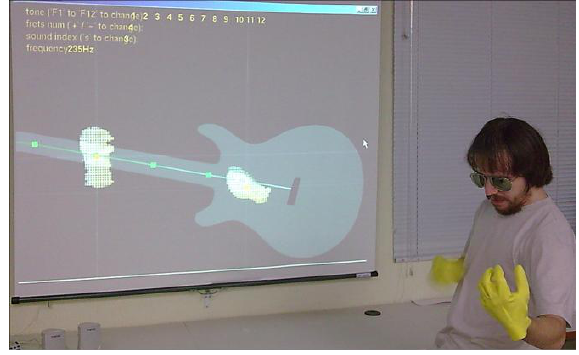
Figure 3. User’s performance during a test of the Air Guitar Framework In 2010, the CapCam device, a prototype for monitoring